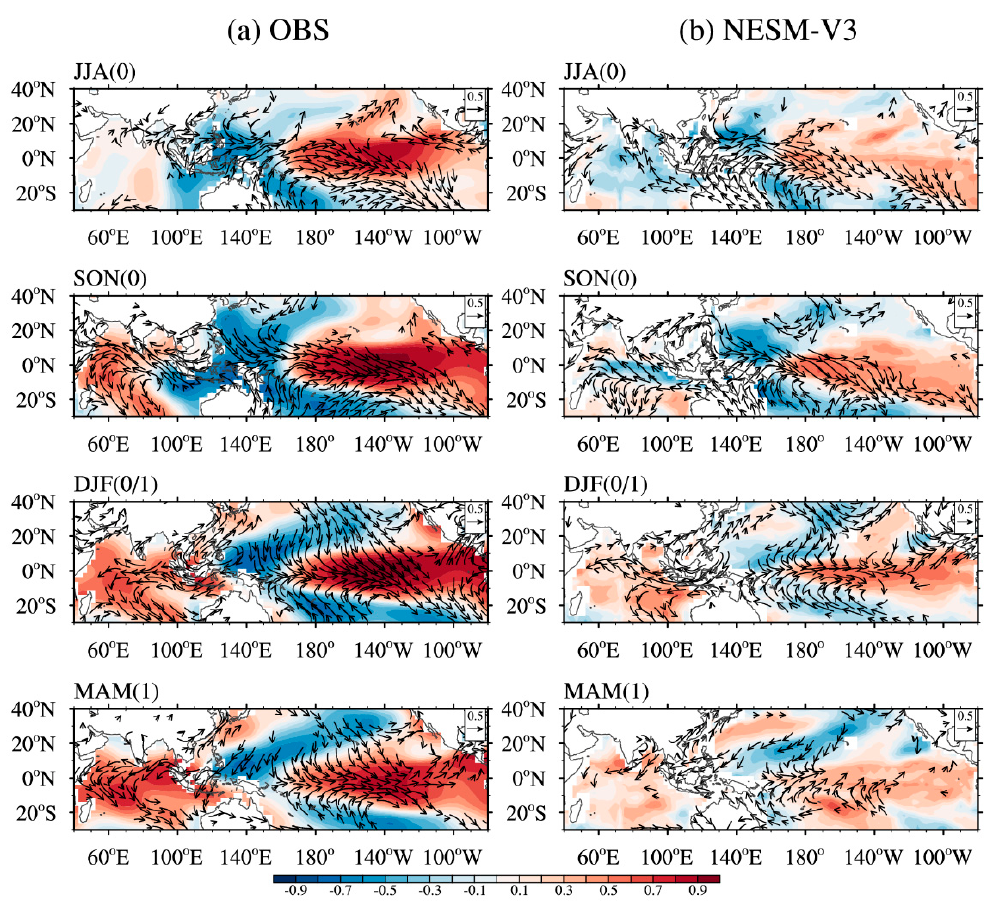
Figure 5. ( a ) Spatial patterns of the observed correlation fields of seasonal sea surface temperature (SST) anomalies (shading) and 850 hPa wind anomalies (vectors) against the corresponding first principal component from JJA(0) to MAM(1). ( b ) Same as in ( a ) except for NESMv3 simulation. NESMv3 is able to capture the observed rainfall evolution with PCC values of 0.74, 0.63, 0.77, and 0.59, respectively, from JJA(0) to MAM(1) (Figure 4a, right panels). In general, NESMv3 overestimates the precipitation over the equatorial eastern Indian Ocean and western Pacific, and the Maritime Continent, and underestimates the precipitation over the western Indian Ocean. NESMv3 reasonably simulates the associated spatial pattern of SST anomalies over the Pacific, but underestimates the amplitude, and the variability center shifts westward (Figure 5b), which may partially contribute to the precipitation bias over the AAM region. A zonal SST dipole with cold water to the east and warm water to the west of the WNP (SIO) anticyclone center maintains (amplifies) the WNP (SIO) anticyclone through local air–sea interaction during a decaying (developing) El Nino. NESMv3 realistically captures the zonal SST dipole associated with the WNP anticyclone in MAM(1), but the dipole and the anticyclone center shift northeastward (Figure 5b). In addition, the model fails to demonstrate the distribution of cold and warm SST around the SIO anticyclone in SON(0) (Figure 5b). These may potentially contribute to the relatively poor performance of NESMv3 in simulating AAM variability during SON(0) and